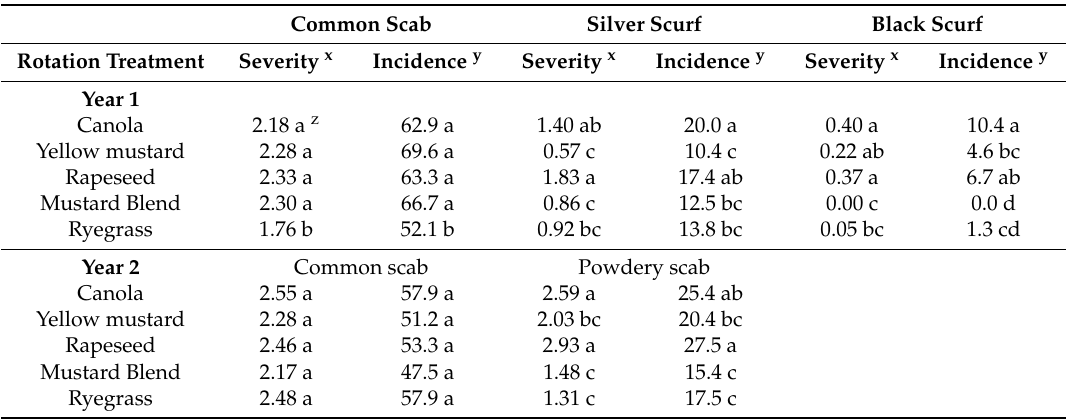
x Severity based on percent of tuber surface covered by lesions; y Incidence of tubers (percentage) with severity rating greater than 2%; z Means within columns for each year followed by the same letter are not significantly different according to Fisher’s protected LSD at P =